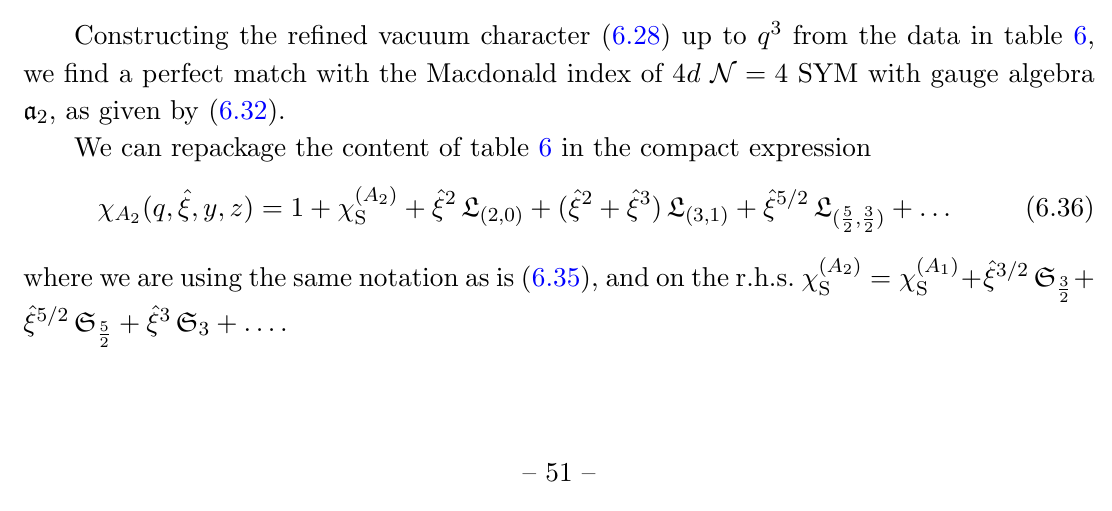
Table 6 . States in the VOA W (cid:0) with (cid:0) = A 2 with h (cid:20) 3. The notation ( j ) R under the sl (2) y symmetry of the small N = 4 SCA, the outer automorphism quantum number r , and the R